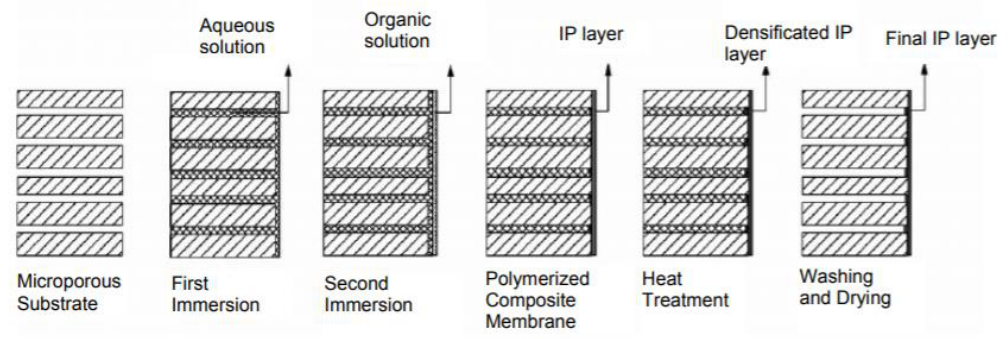
Figure 1. Schematic of interfacial polymerization preparation of TFC membrane. Reprinted with permission from [8], Copyright 2011 IACSIT Publishing.